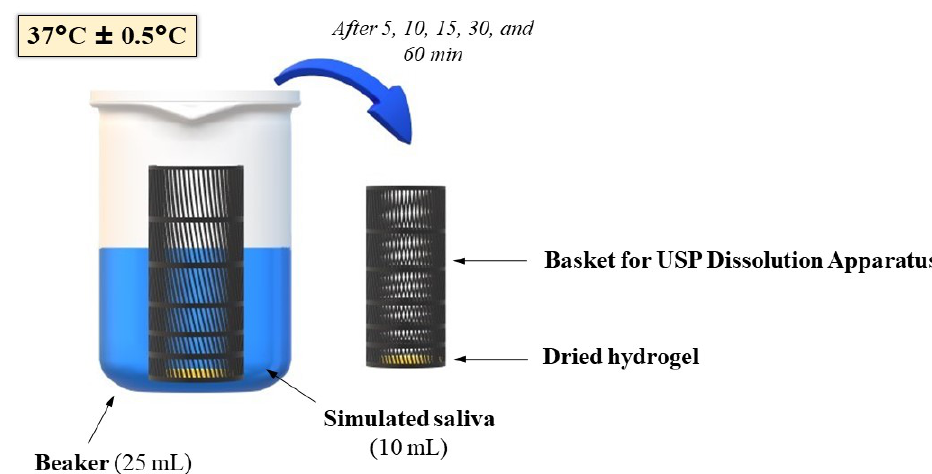
Figure 2. The scheme of the swelling